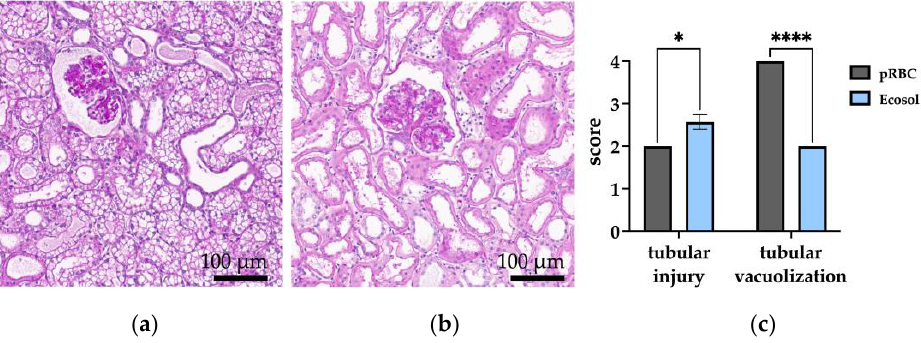
Figure 8. Histological assessment of kidneys after perfusion. ( a ) Exemplary PAS-stained cross- sections of pRBC and ( b ) Ecosol (40-fold magnified); and ( c ) statistical analysis of tubular injury and tubular vacuolization scores after perfusion; * p < 0.05; **** p < 0.0001.